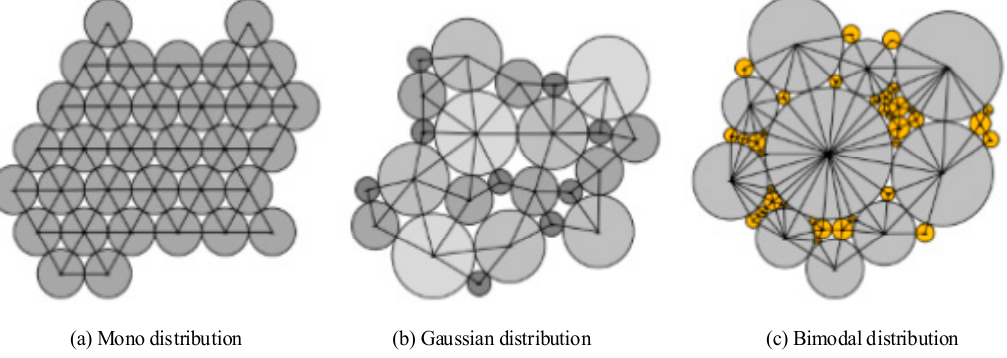
Figure 6. Three different packing types determined by different manners of particle size distributions.